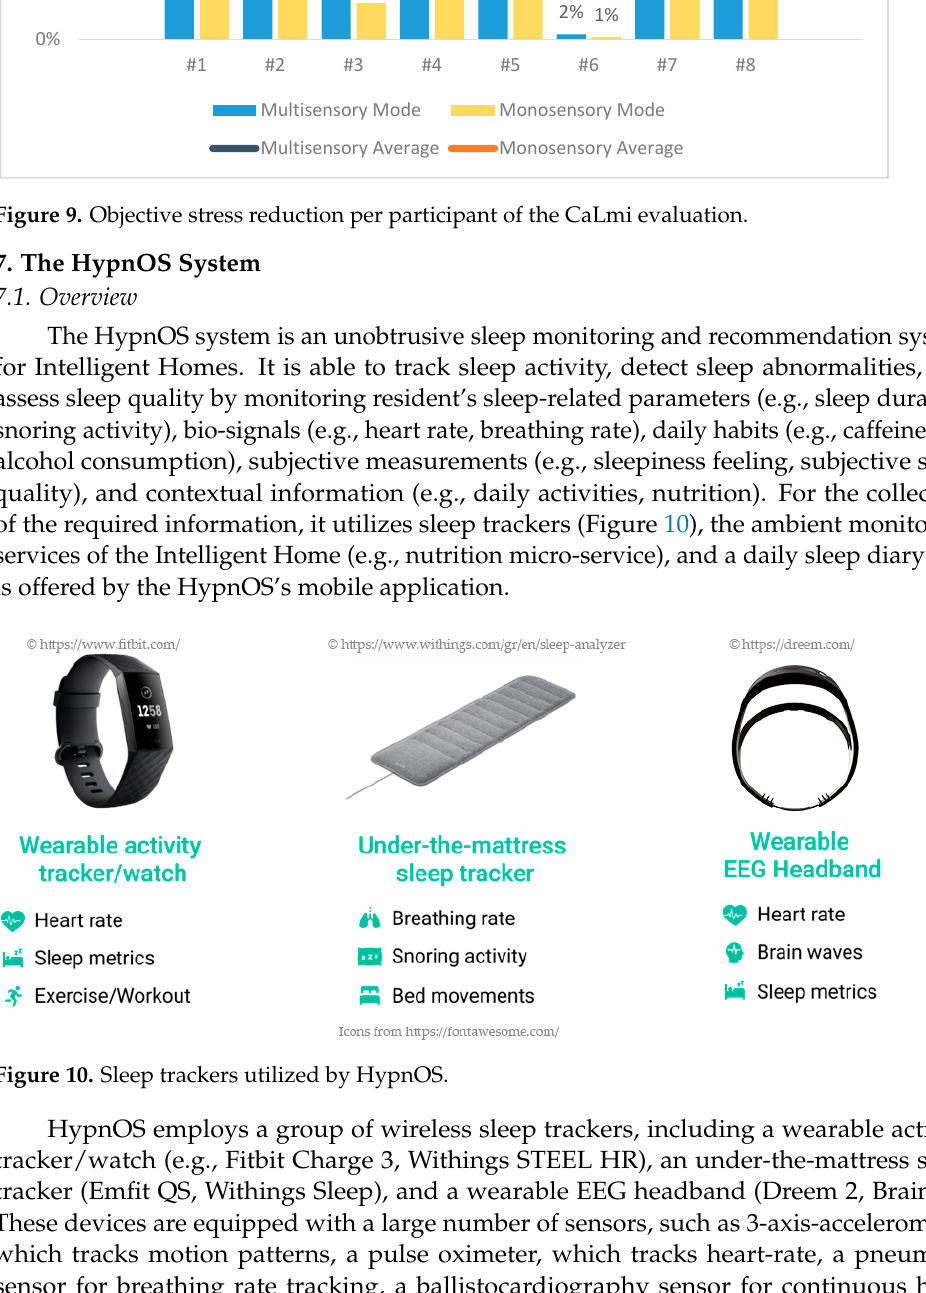
Figure 9. Objective stress reduction per participant of the CaLmi evaluation.